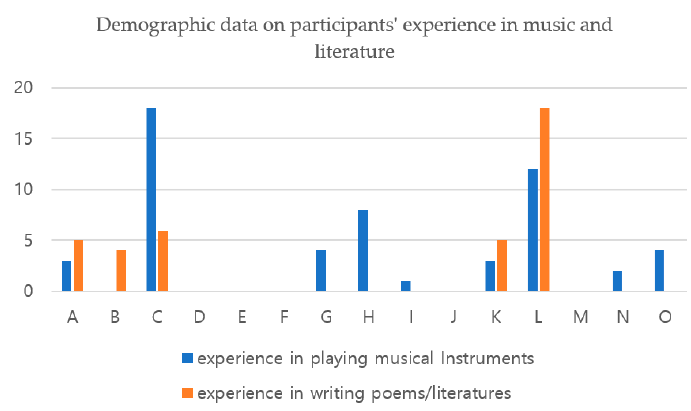
Figure 3. Demographic data on participants’ experience in music and literature.